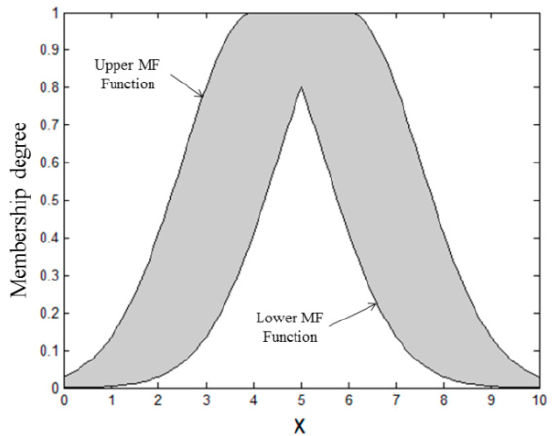
Figure 1. IT2 Gaussian membership function representation.